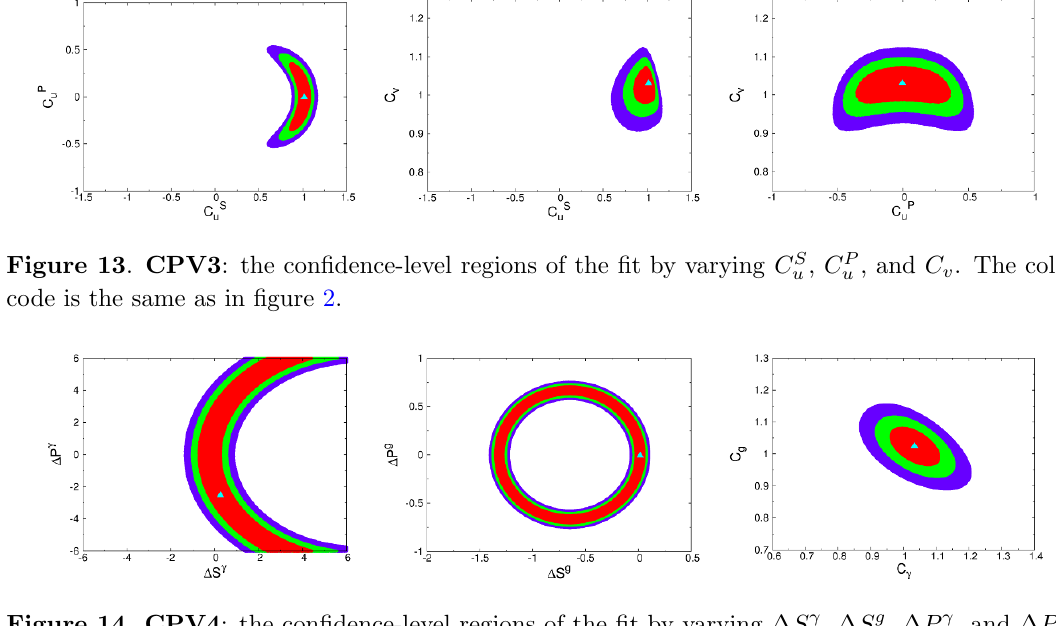
Figure 12 . CPV2 : the con(cid:12)dence-level regions of the (cid:12)t by varying C S is the same as in (cid:12)gure 2.